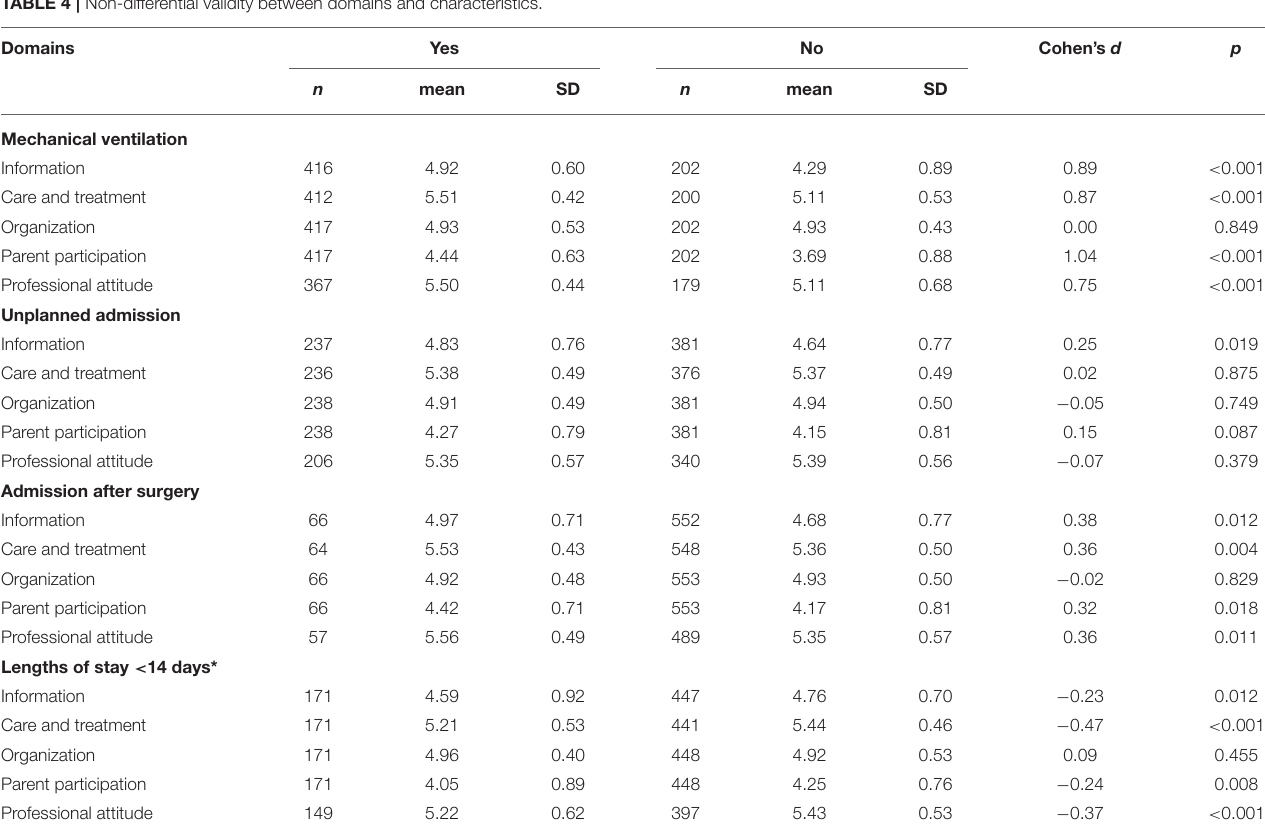
TABLE 4 | Non-differential validity between domains and